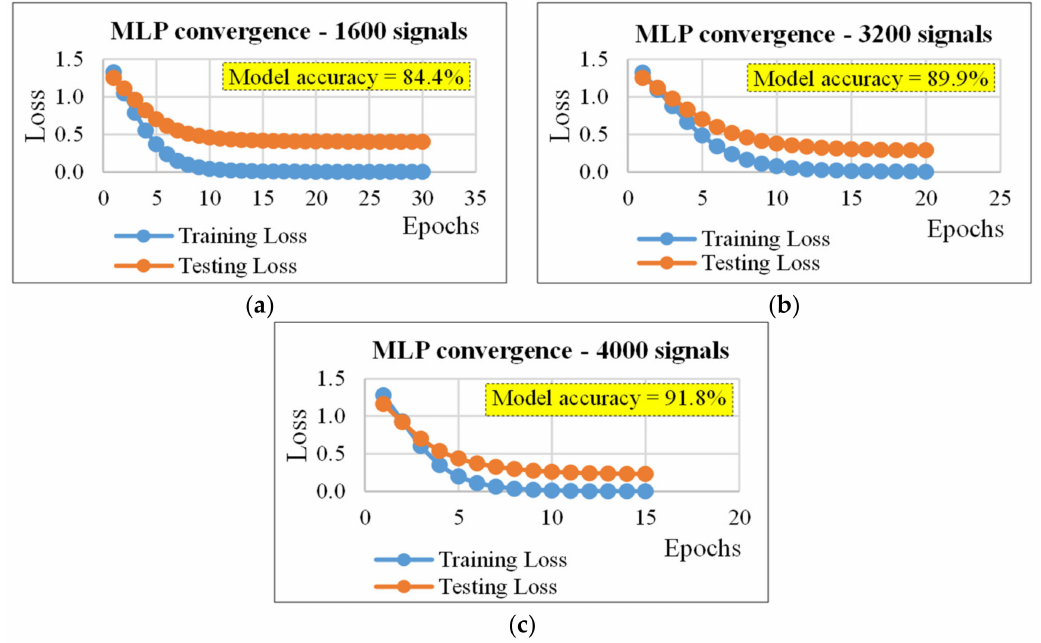
Figure 4. Convergence plots for the MLP (cf. Table 1): ( a ) data set size (D) = 1600 signals, ( b ) D = 3200 signals, and ( c ) D = 4000